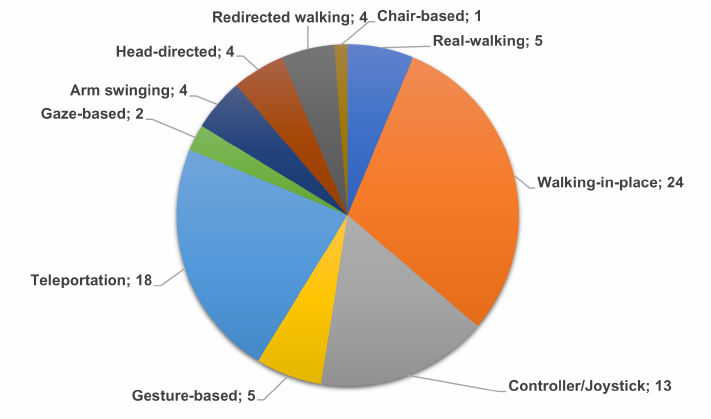
Figure 3. The number of instances of the 10 locomotion techniques, as documented from the 42 reviewed